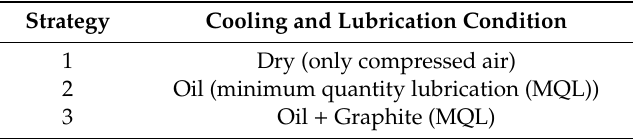
Table 3. Lubrication strategies used (dry / oil / oil + graphite).